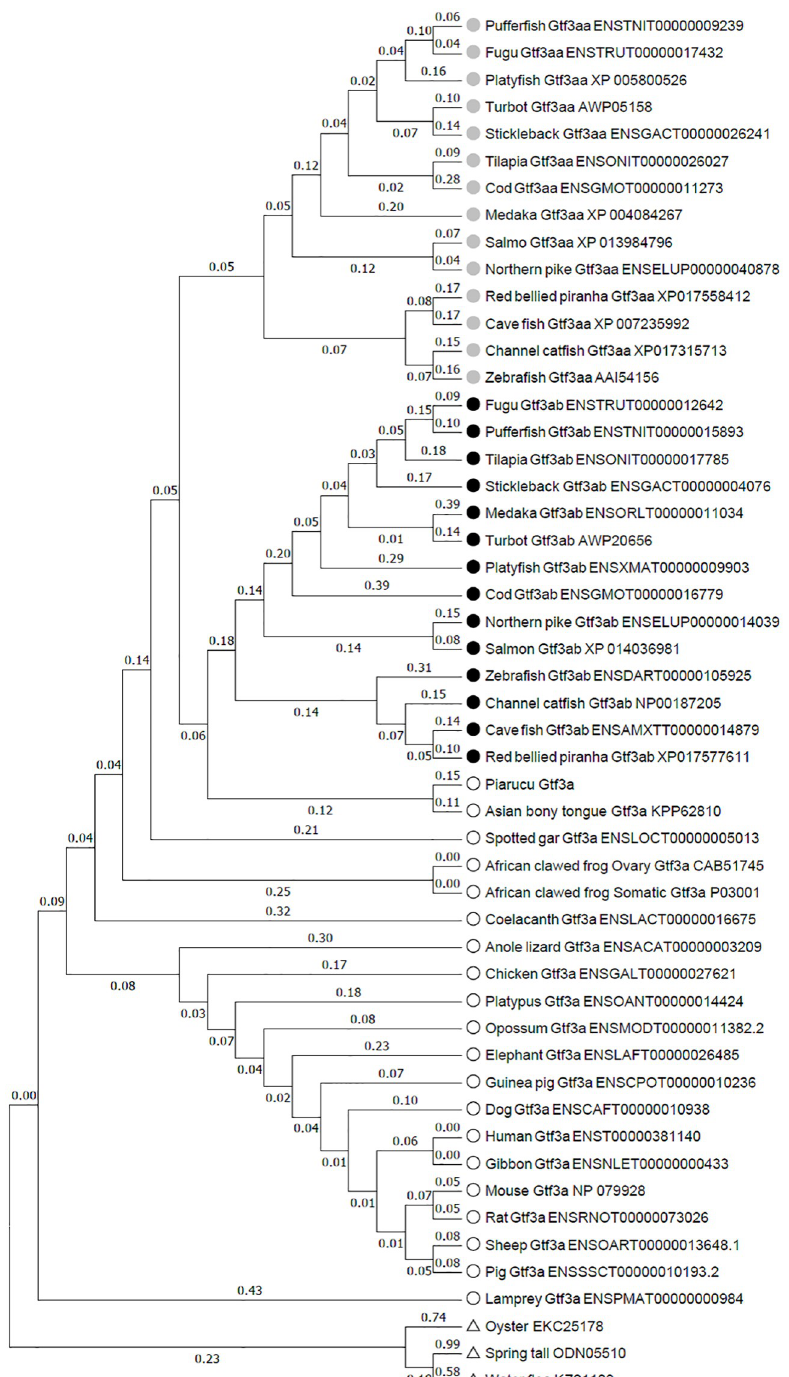
Fig 1. Phylogenetic tree showing the relationship between different animal deduced Gtf3a protein sequences. Sequences were aligned with MEGA7 using MUSCLE (v3.8.31) conFig d for highest accuracy. The evolutionary history was inferred by using the Maximum Likelihood method based on the JTT matrix-based model. The tree with the highest log likelihood (-8390.8717) is shown. Initial tree(s) for the heuristic search were obtained automatically by applying Neighbor-Join and BioNJ algorithms to a matrix of pairwise distances estimated using a JTT model, and then selecting the topology with superior log likelihood value. The tree is drawn to scale, with branch lengths measured in the number of substitutions per site (next to the branches). The analysis involved 51 protein sequences. All positions containing gaps and missing data were eliminated. There were a total of 157 positions in the final dataset. All Gtfab proteins are indicated with black circles, with grey circles for Gtfaa, and white circles for Gtfa in non teleosts and in Ostoglossomorpha . Triangles mark proteins coded by invertebrate Gtf2a orthologs used as outgroups. https://doi.org/10.1371/journal.pone.0227690.g001 PLOS ONE | https://doi.org/10.1371/journal.pone.0227690 January 30,